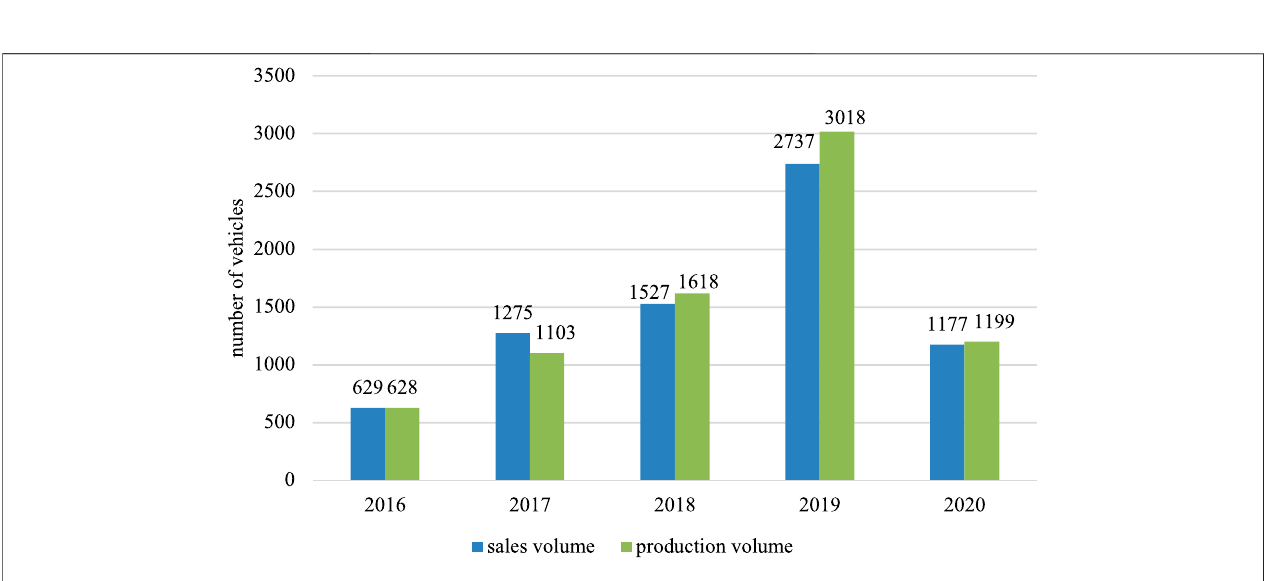
Frontiers in Environmental Science |